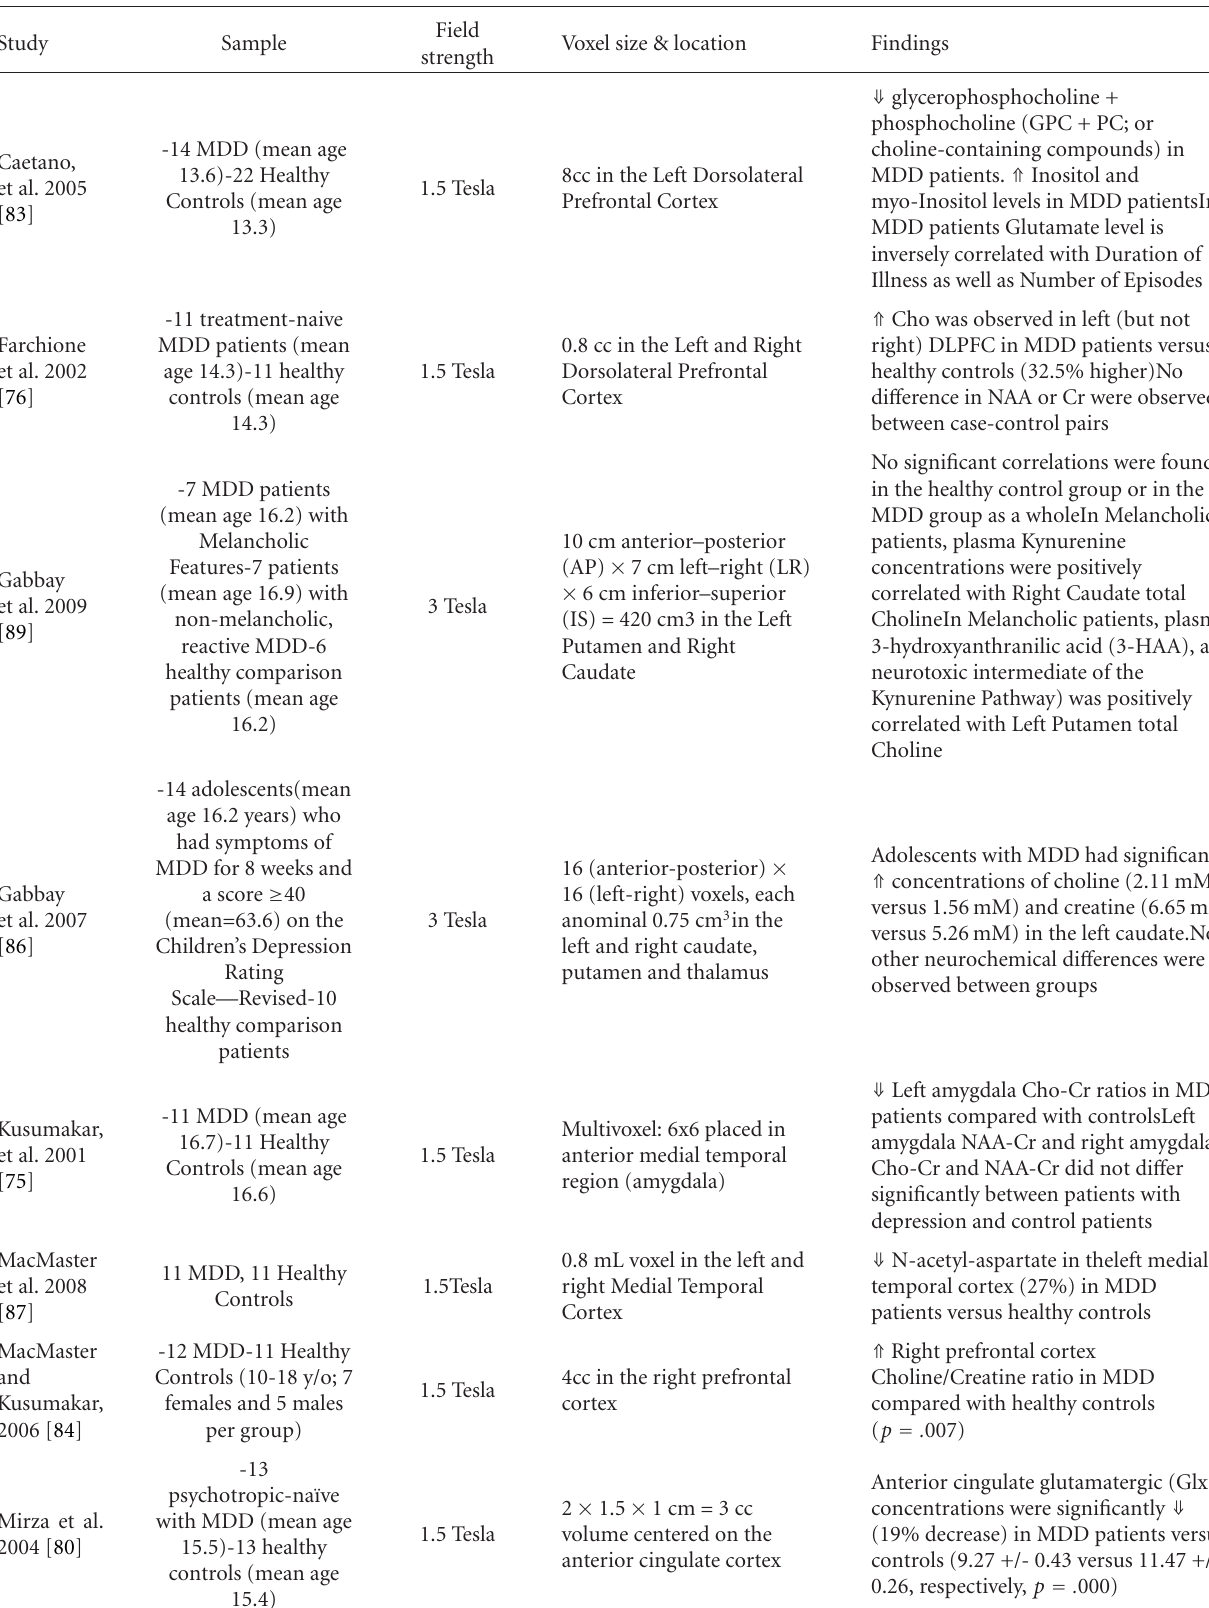
Table 1: Magnetic resonance spectroscopy studies of pediatric major depressive